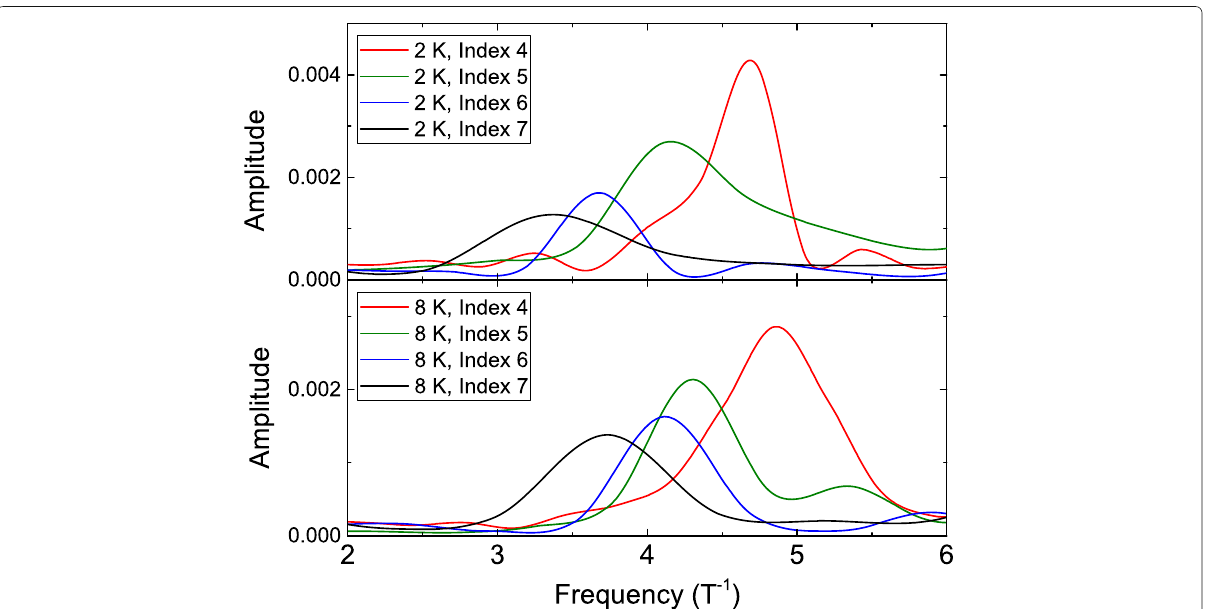
Fig. 3 The fast Fourier transform of the dR / dB at different Landau levels and temperatures. The higher oscillation frequency peak is observed at lower Landau levels